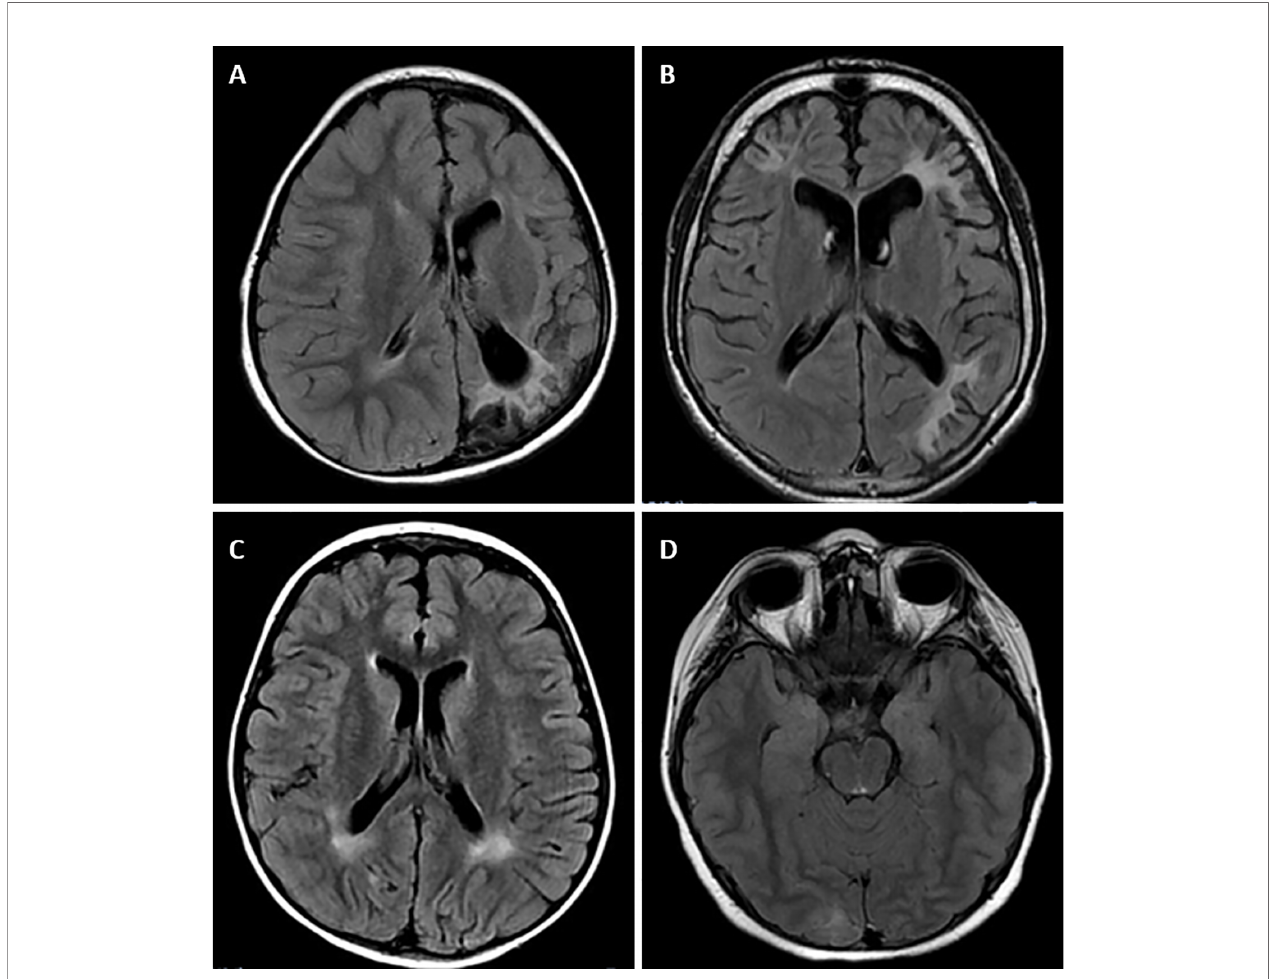
FIGURE 1 | Magnetic resonance imaging alterations in patients with GSD Ia. (A) (Patient #1). Extensive areas of gliosis and encephalomalacia are observed, particularly in the cortical and subcortical areas of the left occipital and parietal lobes, as well as along the frontoparietal transition with high convexity and compensatory ectasia of corresponding portions of the ipsilateral lateral ventricle. Moreover, lesion foci are observed, which are probably related to hemosiderin deposits, extending to the posterior aspects of the nucleocapsular region with signs of chronic Wallerian degeneration of the corresponding cortico-spinal tract. There is substantial left-sided cerebral atrophy. (B) (Patient #12) Retracted lesions affecting the cortex and subcortical white matter of the bilateral frontal regions and the left parieto-temporal transition are evident. These changes are suggestive of encephalomalacia and vascular sequelae. (C) (Patient #9) Oval foci showing high- intensity on T2-weighted sequences in the central white matter and projecting close to the peritrigonal regions. These nonspeci fi c changes could represent gliosis around the perivascular spaces (terminal myelination areas). (D) (Patient #10) Small retracted lesions affecting the posterior occipital poles with loss of volume, especially on the right side, suggestive of lesions occuring secondary to